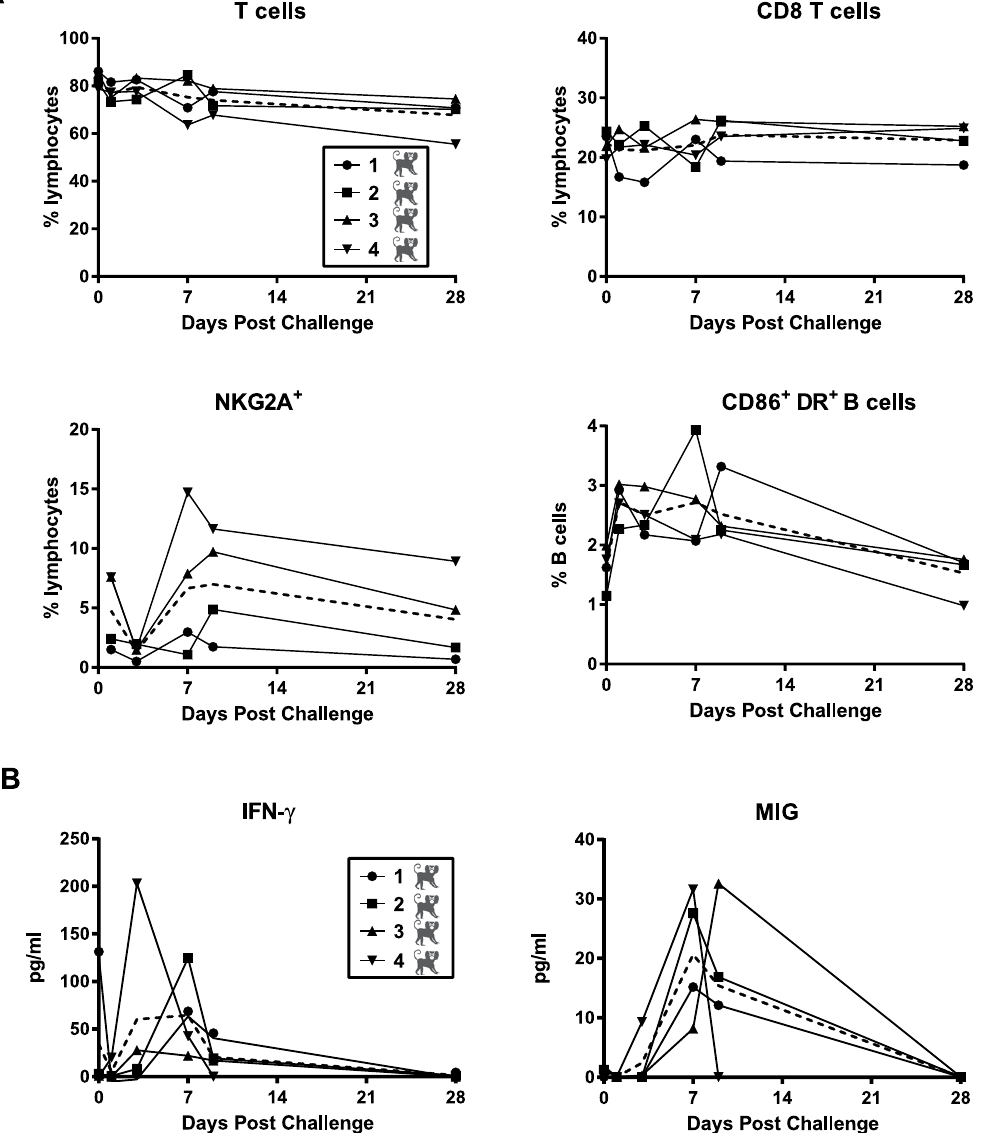
Figure 3. Changes in lymphocyte subsets and circulating cytokines after acute ZIKV infection. ( A ) Polychromatic flow cytometry was used to identify T cells (upper left), CD8 T cells (upper right), NKG2A + NK cells (lower left), and CD20 + B cells expressing activation markers CD86 and HLA-DR (lower right). ( B ) Increases in protein expression of interferon-gamma (IFN- γ ) and monokine induced by IFN- γ (MIG) were detected using a Luminex